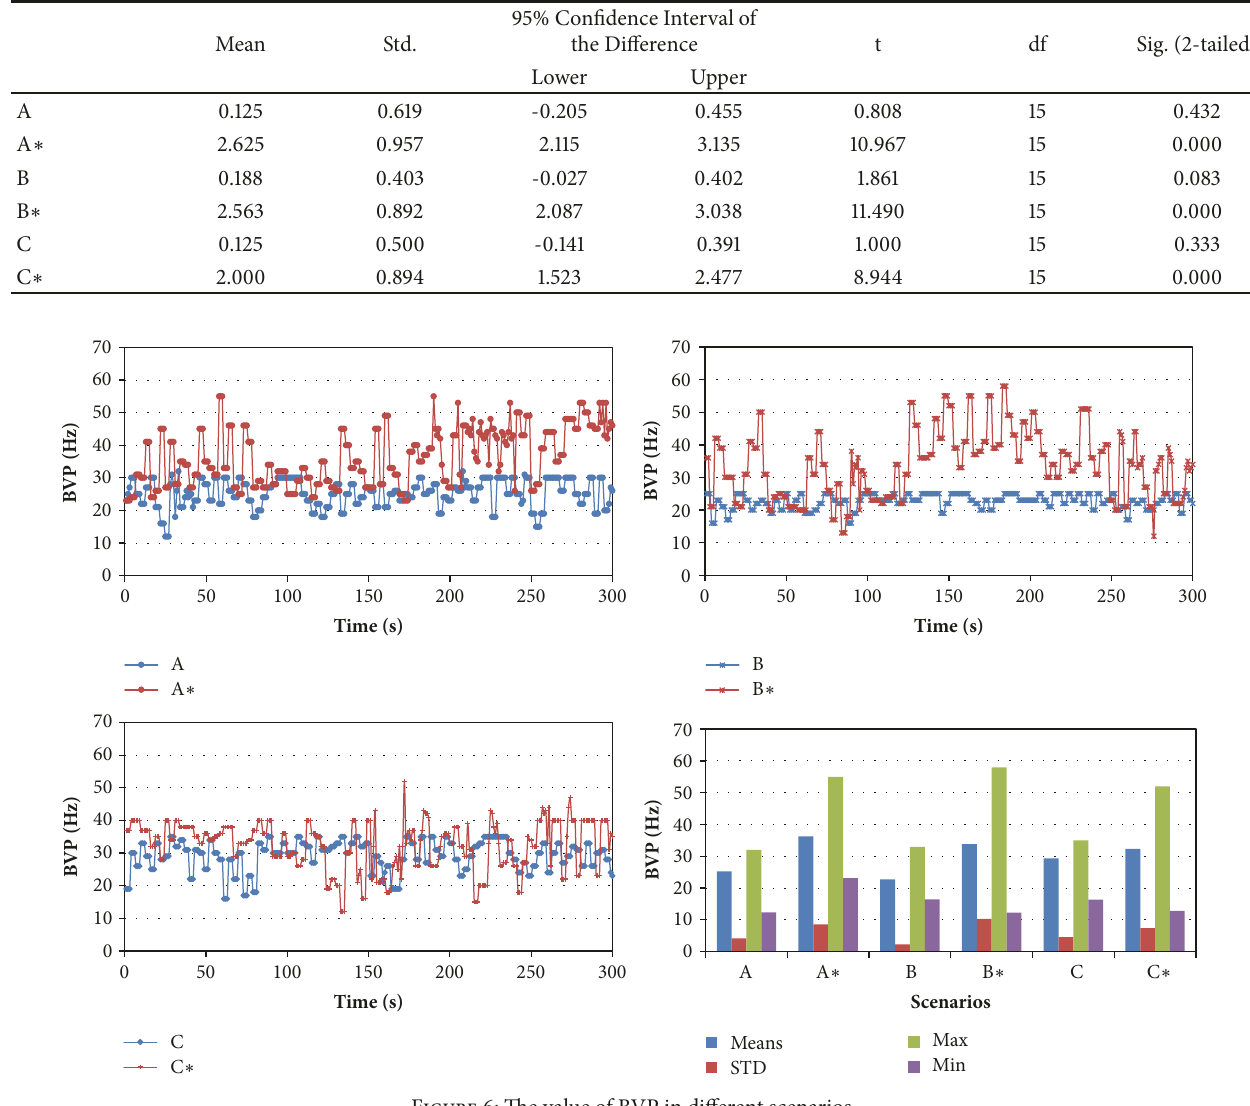
Table 2: The paired-samples t-test of anger level between different scenarios.